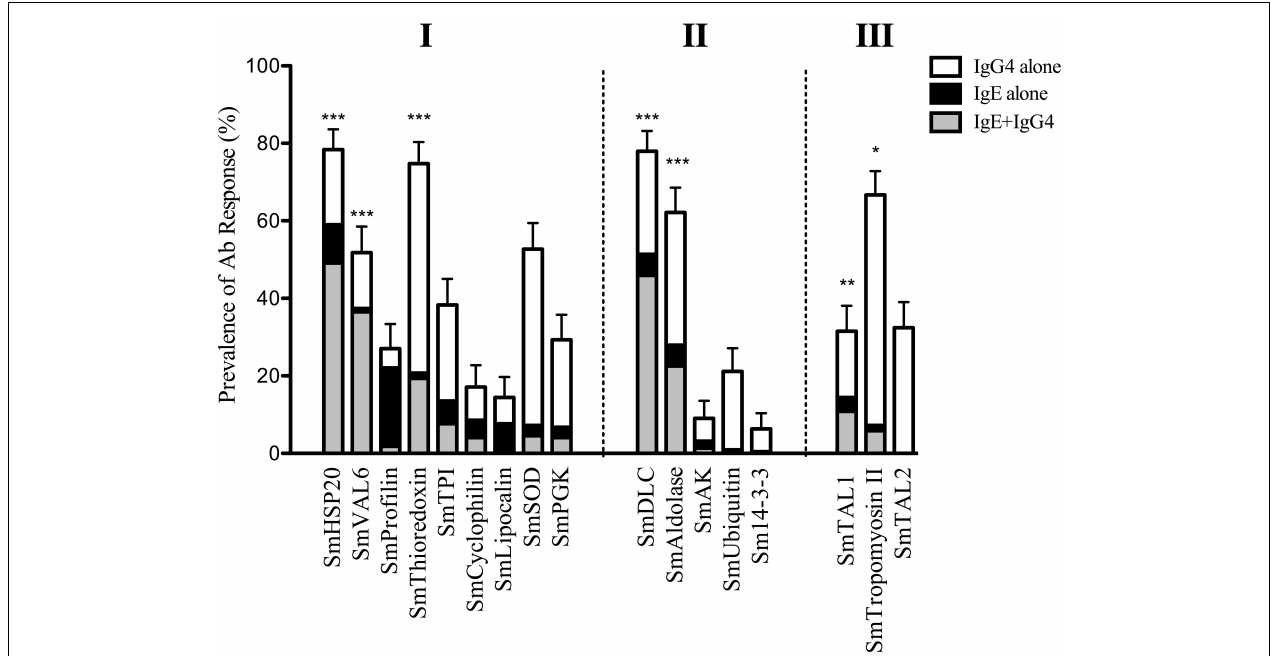
to compare the prevalence of individuals responding with IgE alone vs. those responding with IgE and IgG4 together (* p < 0.05, ** p < 0.01, *** p < 0.001). Proteins were grouped into predicted IgE-binding antigens (I), antigens without known allergenic domains (II), and confirmed IgE-binding antigens